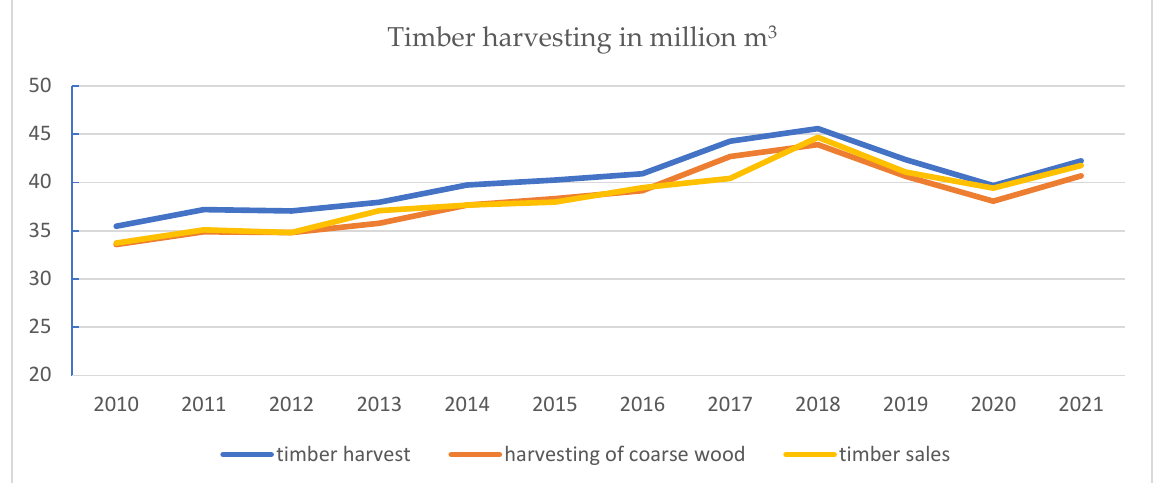
Figure 1. Timber harvest, sales, exports and imports from 2010–2021 [29–37]. Poland currently processes about 40 million m 3 of wood per year, of which sawmills process about 25 million m 3 [35]. The most popular and most processed wood raw material is pine. It accounts for about 61% of the processed raw material. The other species are as follows: spruce (6%), fir (4%), beech (7%), oak (6%), birch (5%) and others that